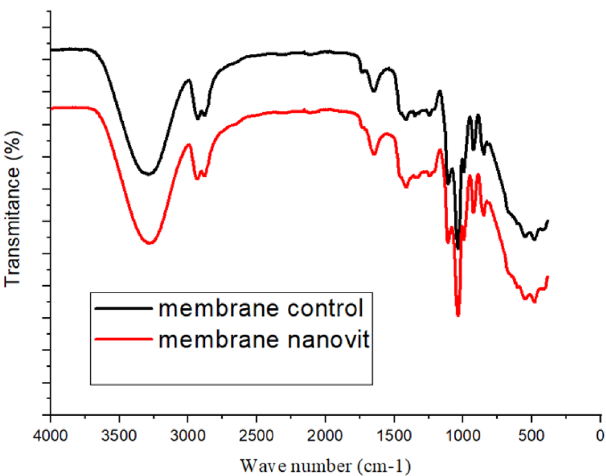
Figure 3. FT-IR spectra for the control and nanovit